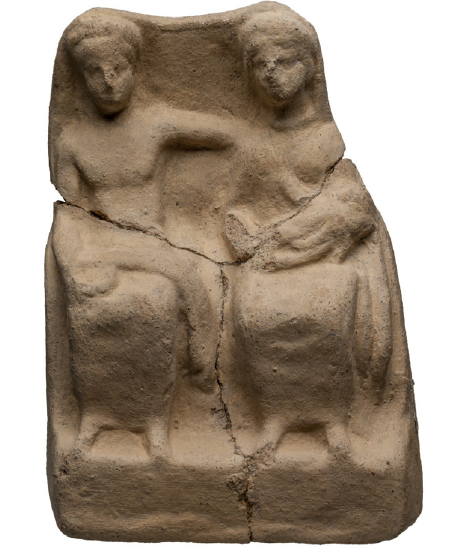
Figure 5. Veii Campetti. © MiBAC. Museo Nazionale Etrusco di Villa Giulia. Foto Mauro Benedetti. From Pedrucci, “Maternità e